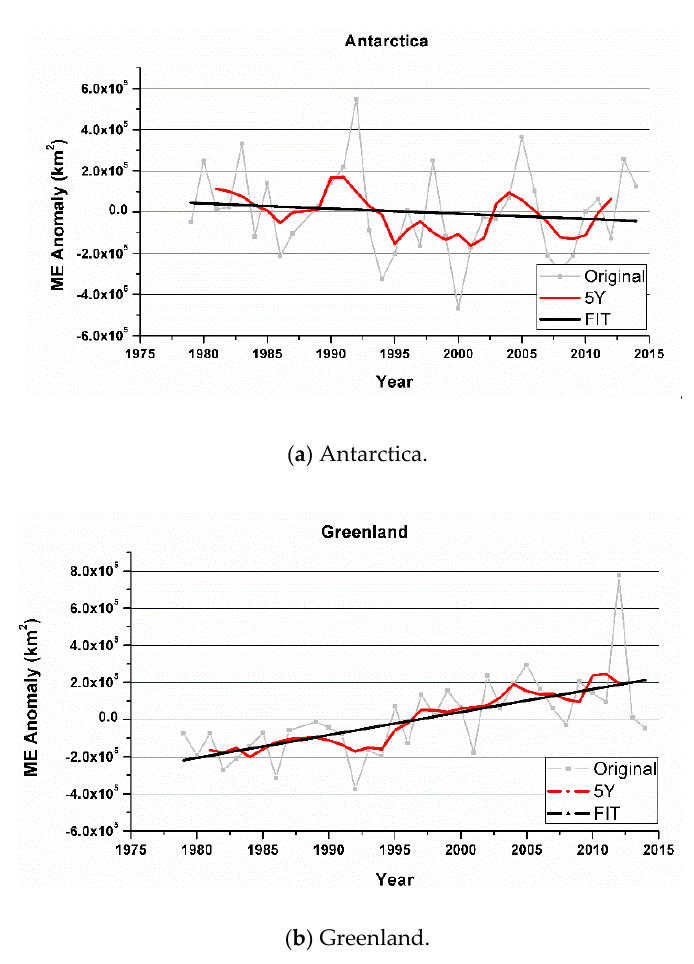
Figure 7. Melt extent (ME) anomaly with respect to the 1978–2014 average, its five-year running mean (red line) and the least square linear fit (thick black line) for the ( a ) Antarctica and ( b ) Greenland ice